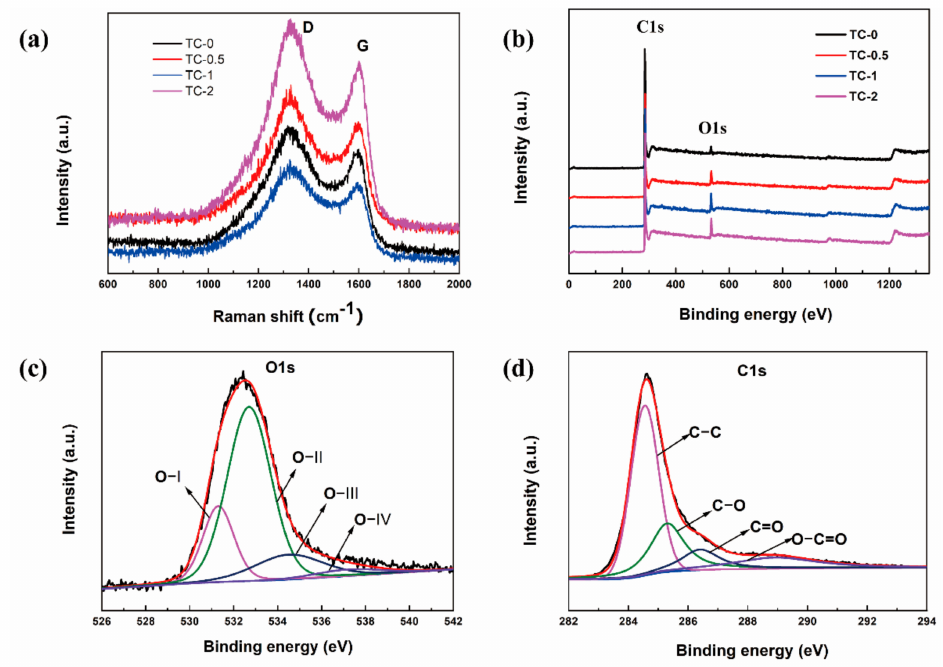
Figure 5. ( a ) Raman spectra and ( b ) XPS survey spectra of TC-0, TC-0.5, TC-1, TC-2. High-resolution ( c ) O1s and ( d ) C1s of